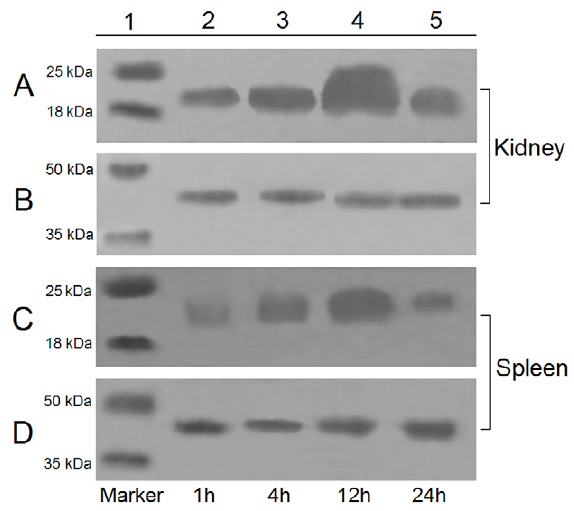
Figure 4. CsISG15 production in kidney and spleen in response to pathogen infection. Tongue sole were infected with megalocy- tivirus for 1 h, 4 h, 12 h, and 24 h, and CsISG15 production in kidney (A and B) and spleen (C and D) was determined by Western blot with antibodies against rCsISG15 (A and C) or b -actin (B and D).